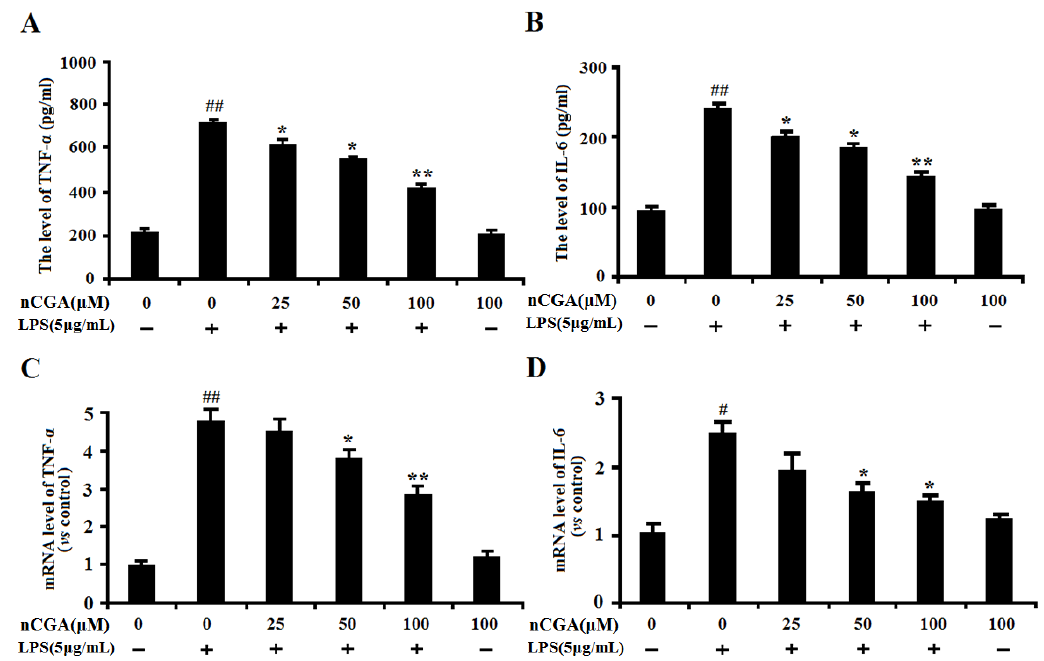
Figure 2. Effects of nCGA on inflammatory cytokines production in Lipopolysaccharide (LPS)-stimulated A549 cells. A549 cells were pretreated with or without various concentrations of nCGA (0, 25, 50, 100 µ M) for 2 h before LPS (5 µ g / mL) stimulation for another 24 h. ( A , B ) The levels of TNF- α , IL-6 were detected in the culture medium by ELISA kits. ( C , D ) The mRNA levels of TNF- α and IL-6 were detected by RT-PCR. The values represent the mean ± SD of three independent experiments, significant differences between different groups. # p < 0.05, ## p < 0.01 vs. control group, * p < 0.05, ** p < 0.01 vs. LPS alone.